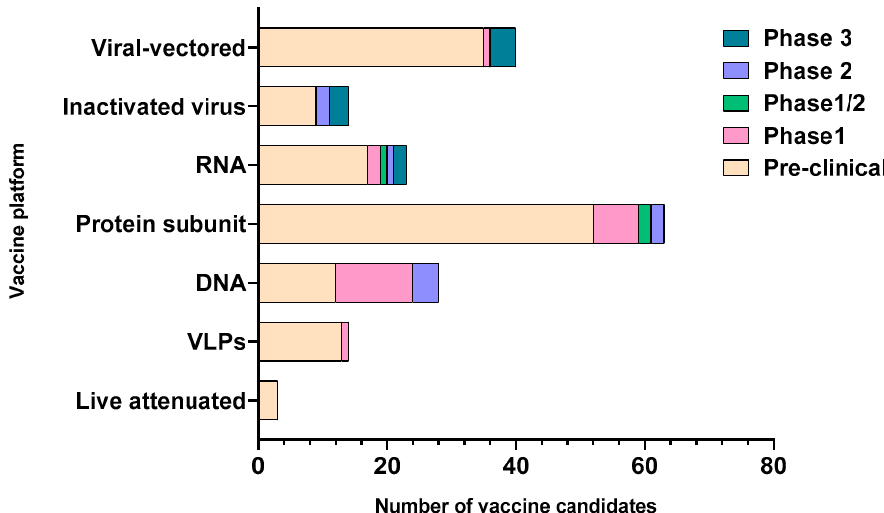
Figure 2. Graphical representation of the vaccine candidates with respect to their clinical stages of development. The number of candidates on the x axis are compared for each of the major vaccine platforms shown on the y axis. The clinical stage for the vaccine candidates in each platform is depicted by color-coded legends on the right of the graph. The graph is constructed based on the data obtained from the World Health Organization; draft landscape of COVID-19 candidate vaccines and Coronavirus Vaccine tracker. VLPs-virus-like particles, RNA-ribonucleic acid, DNA-deoxyribonucleic acid.